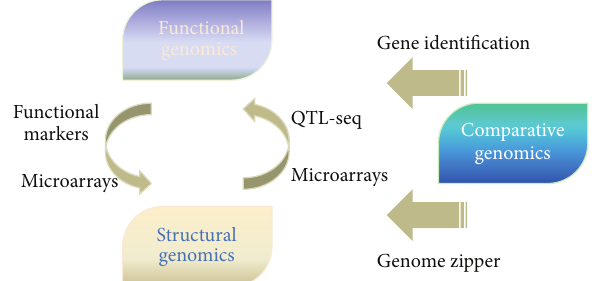
Figure 1: Functional, structural, and comparative genomics approaches are highly interrelated. For example, microarrays can be used either to anchor markers to genome maps or to analyze gene expression; functional markers indicate both phenotypes and genetic locations; QTL-seq utilizes a reference genome sequence to isolate QTLs based on phenotypic variation. As more structural genomics information becomes available, comparative genomics tools such as genome zippers can be used both to elucidate the structure of unsequenced genomes and as a shortcut to design targeted functional